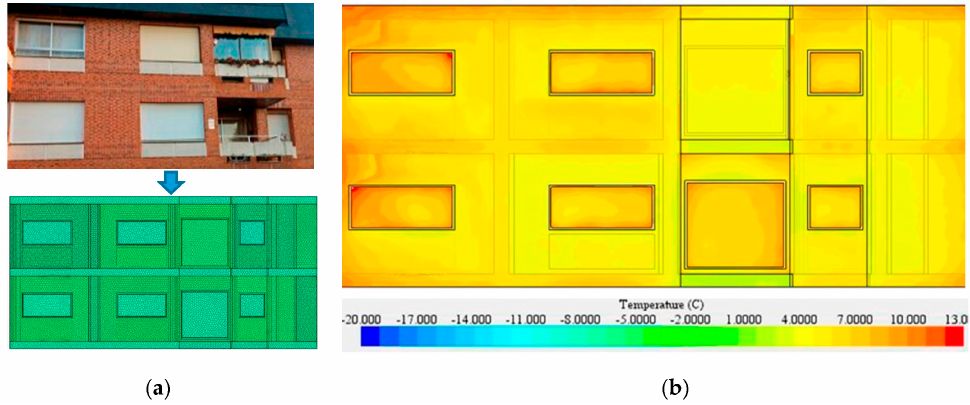
Figure 5. Modelling. ( a ) Studies area and mesh schematized; ( b ) Surface temperature of the facade (°C).